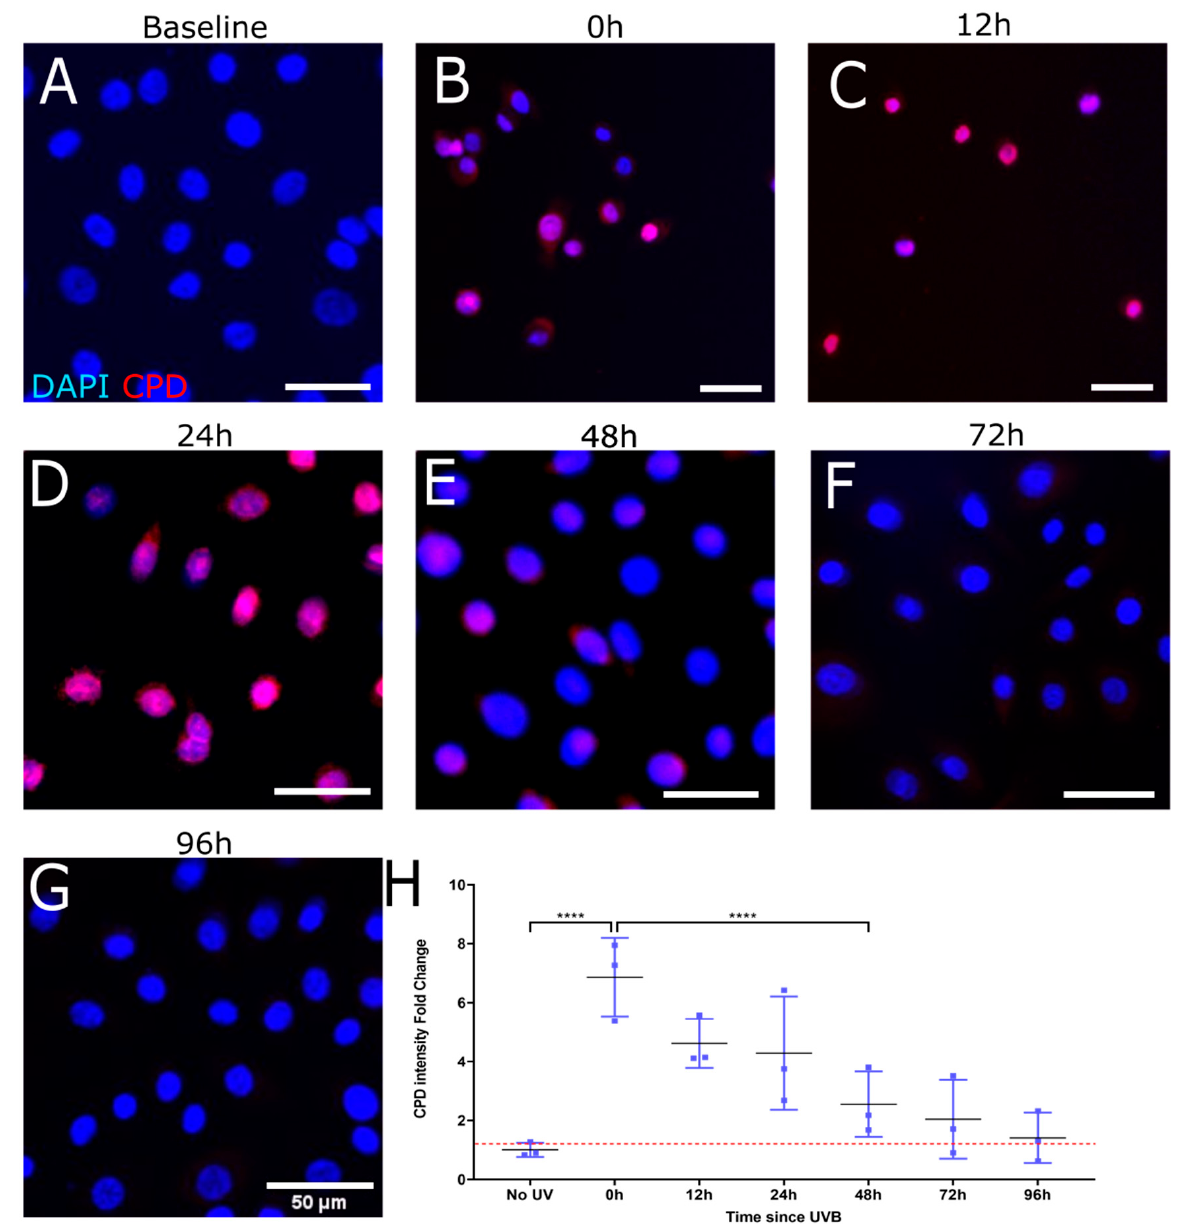
Figure 2. Representative immunofluorescence images illustrating recovery of induced CPD in HLE following UVB exposure. Merged images show nuclei stained blue (DAPI) and CPDs stained red. Mean fluorescence measurements were tracked over the course of 96 h after 0.03 J/cm2 UVB ( B – G ). A non-irradiated control was used for comparison ( A ) and to set a baseline when quantifying fold change in CPD immunofluorescence ( H ). CPD immunofluorescence was highest at 24 h (**** for p < 0.001) ( D ). Each data point was analyzed from 3 donors, each giving 3 images of over 500 cells per image.